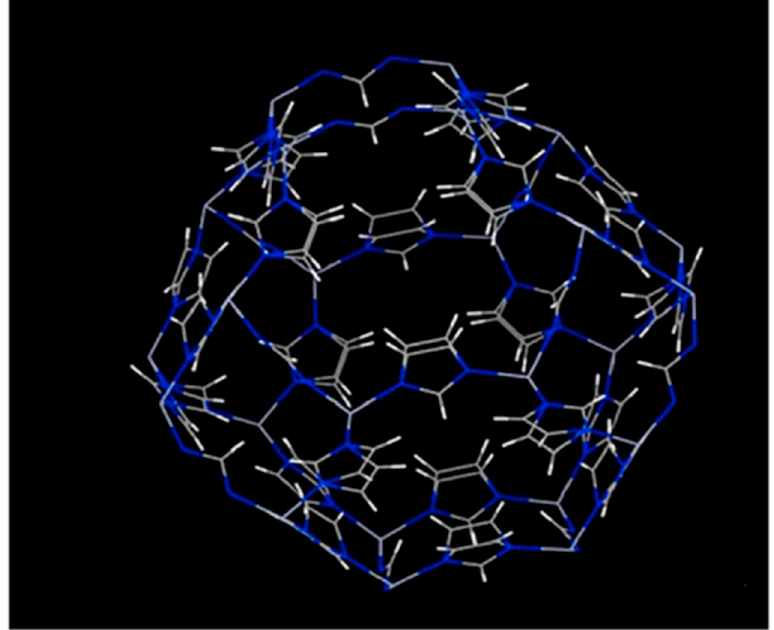
Figure 2. Simulated structure of zeolite imidazole framework (ZIF)-8 [38].